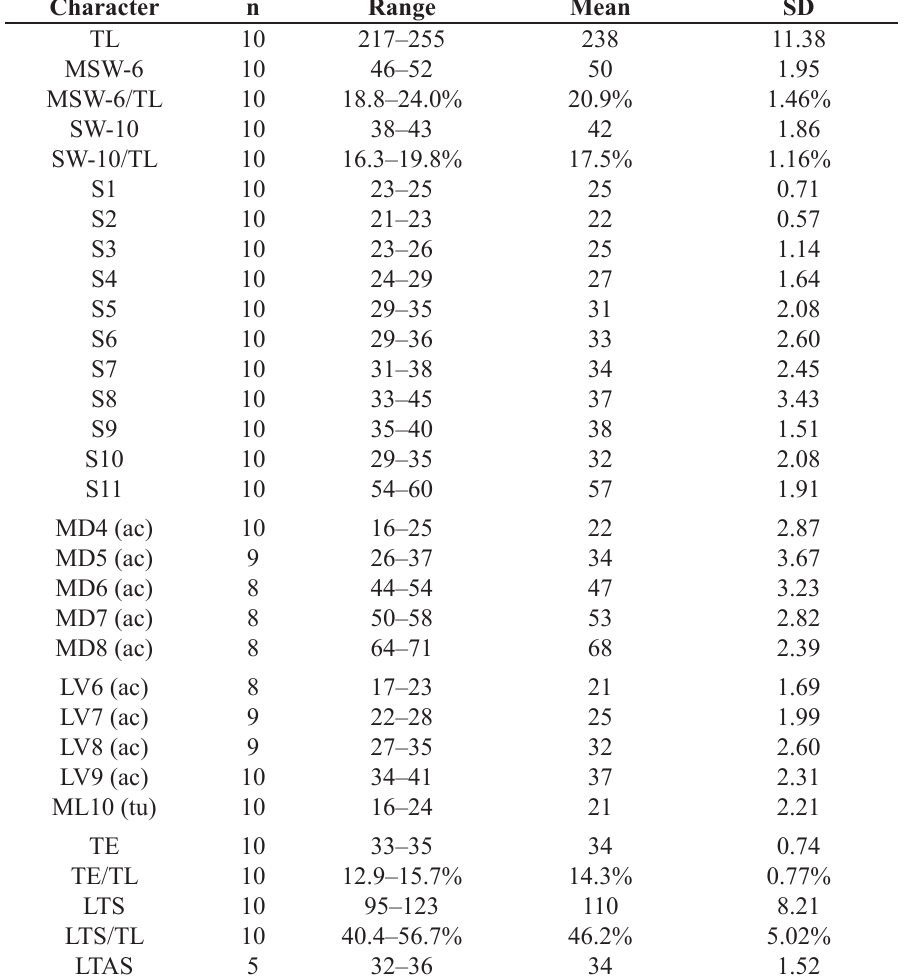
Table 14. Measurements from light microscopy of Echinoderes yamasakii sp. nov. (in µm), including number of measured specimens (n) and standard deviation (SD). Abbreviations: (ac) = acicular spine; LTAS = lateral terminal accessory spine; LTS = lateral terminal spine; LV = lateroventral; MD = middorsal; ML = midlateral; MSW-6 = maximum sternal width, measured on segment 6 in this species; S = segment lengths; SW-10 = standard width, always measured on segment 10; TE = tergal extension; TL = trunk length; (tu) =